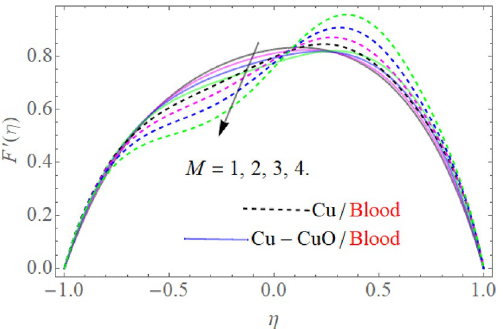
Figure 2. M influence on F ′ (η) .